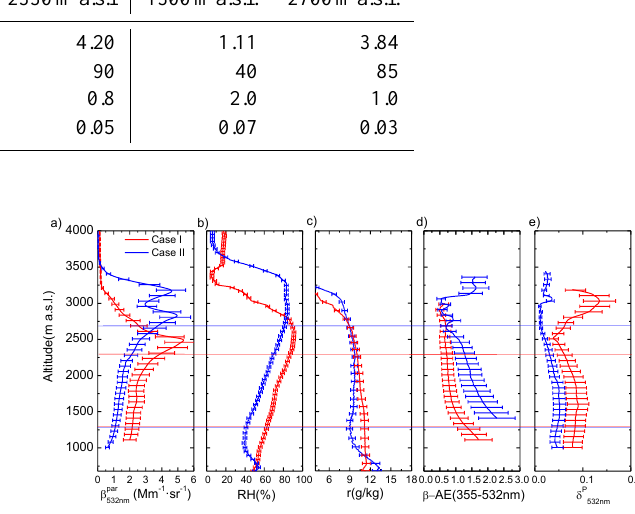
Figure 3. (a) β P retrieved with Klett–Fernald algorithm 532nm (LR = 65 sr for Case I and LR = 70 for Case II) from 20:30 to 21:00UTC on Case I and 20:00 to 20:30UTC on Case II (b) RH profiles from the radiosounding launched at 20:30UTC on Case I and at 20:00UTC on Case II. (c) r profiles from the radiosound- ing launched at 20:30UTC on Case I and at 20:00UTC on Case II. (d) β -AE(355–532nm) retrieved with Klett–Fernald algorithm for the same periods. (e) δ P retrieved from lidar data for the same 532nm periods. Horizontal lines represent the height limits of the aerosol layers selected for the analysis in Case I (red line) and Case II (blue